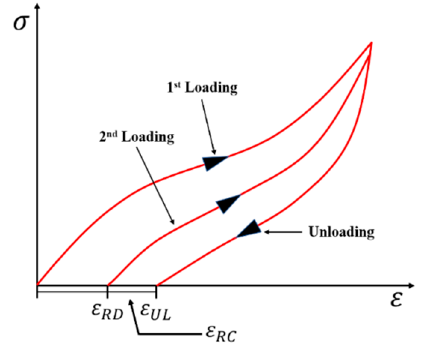
Figure 9. Schematic drawing of hysteretic behavior.